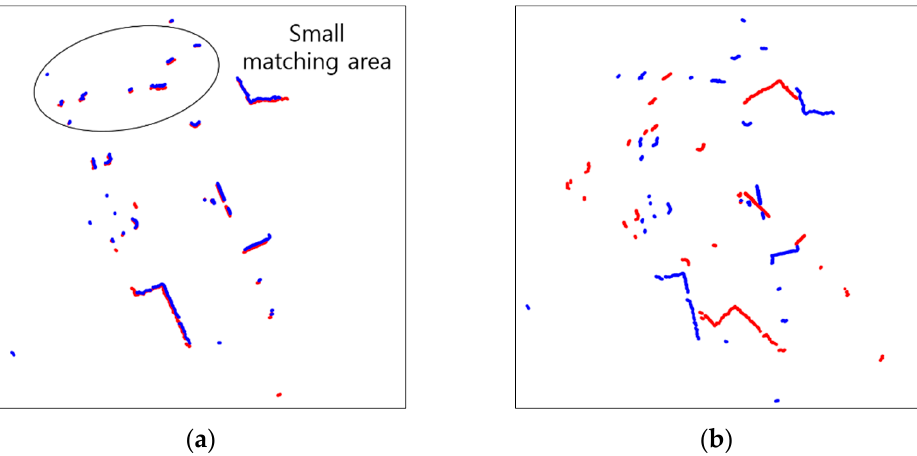
Figure 16. Scan matching images in environment 4 (Red: Previous scan, blue: current scan). ( a ) Normal matching images; ( b ) faulty matching images.